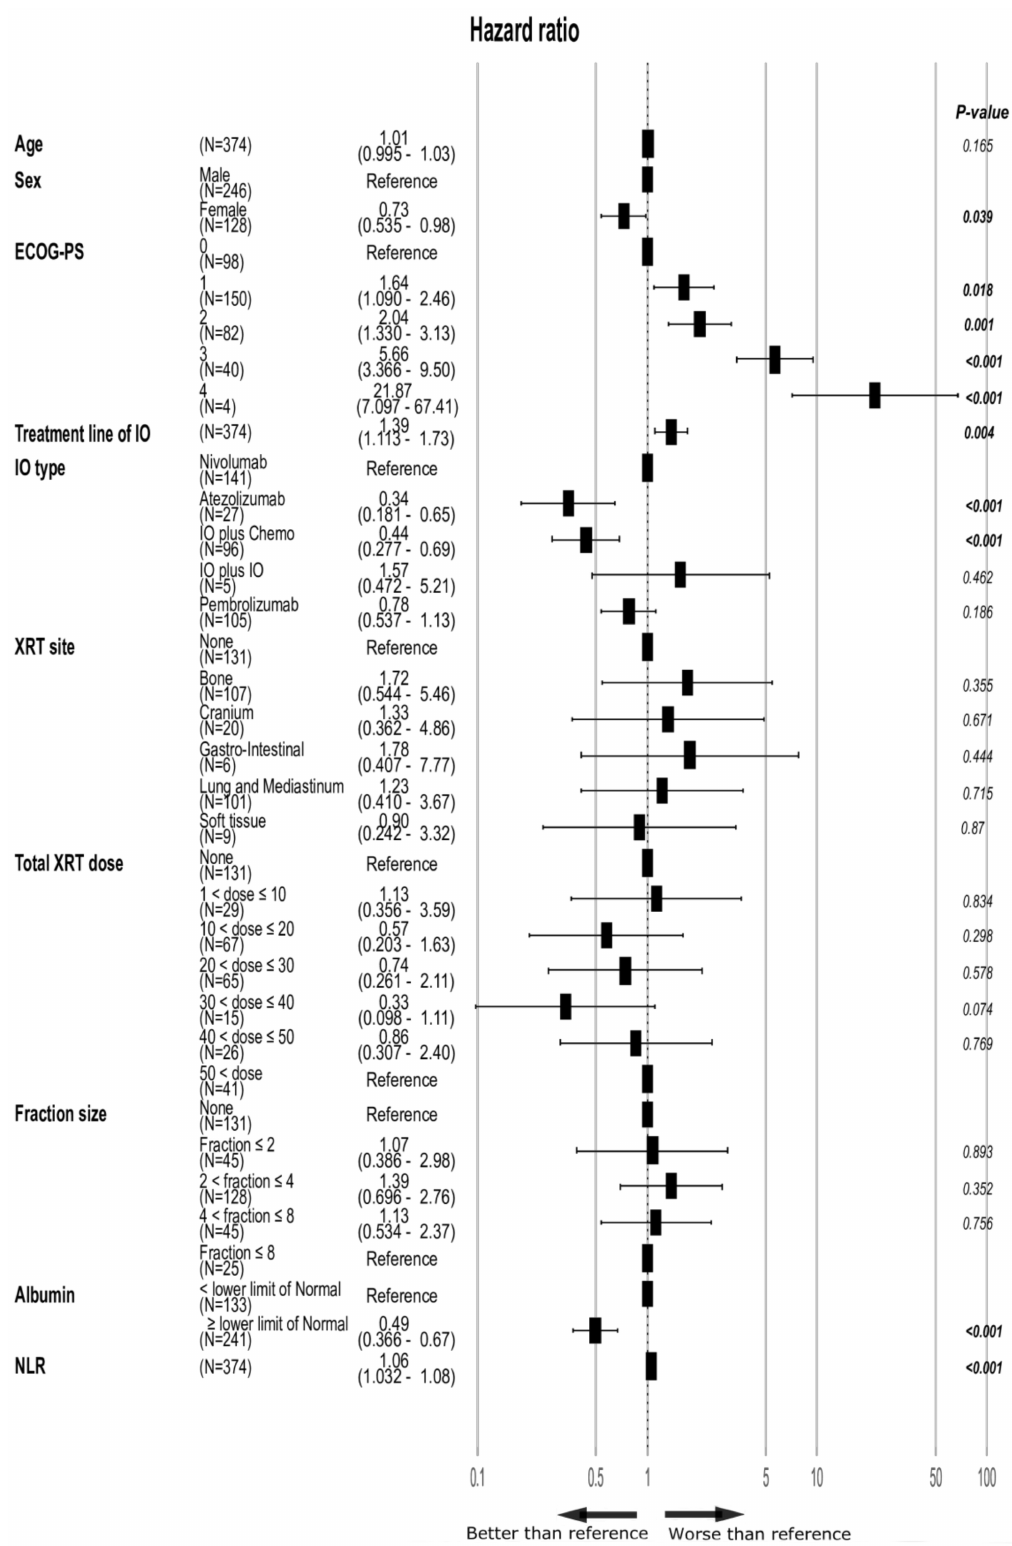
Figure 4. Forest plot of the multivariate evaluation of the factors affecting OS ( n = 374, excluding patients with no blood test results available). Total XRT dose and fraction size are presented in Grays. p -values of statistically significant hazard ratios are in bold. XRT timing—related to timing relative to IO initiation; ECOG-PS: performance status; XRT: radiotherapy; IO: immunotherapy; Chemo: chemotherapy; Tx: treatment; NLR: neutrophil-to-lymphocyte